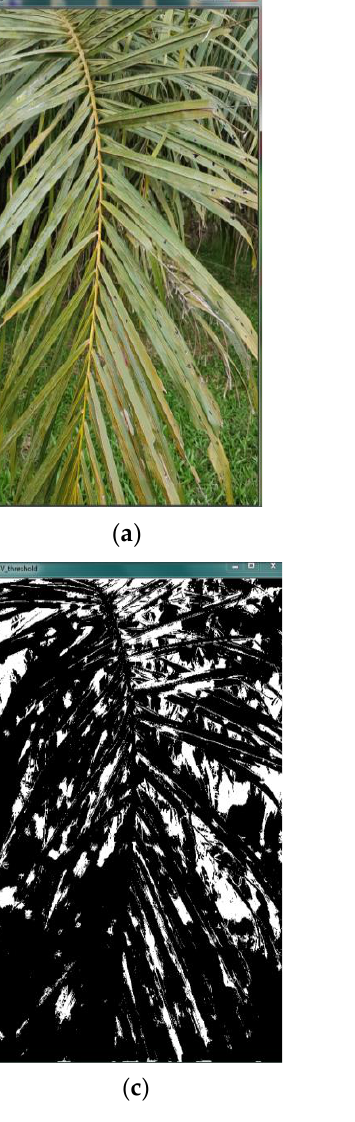
Table 9. Accuracy detection using different color spaces.